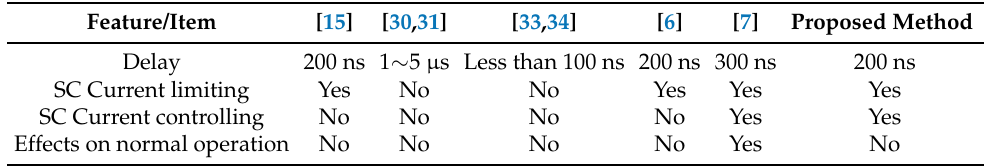
Table 6. Material specifications in the developed FEM model of SiC MOSFET power module.